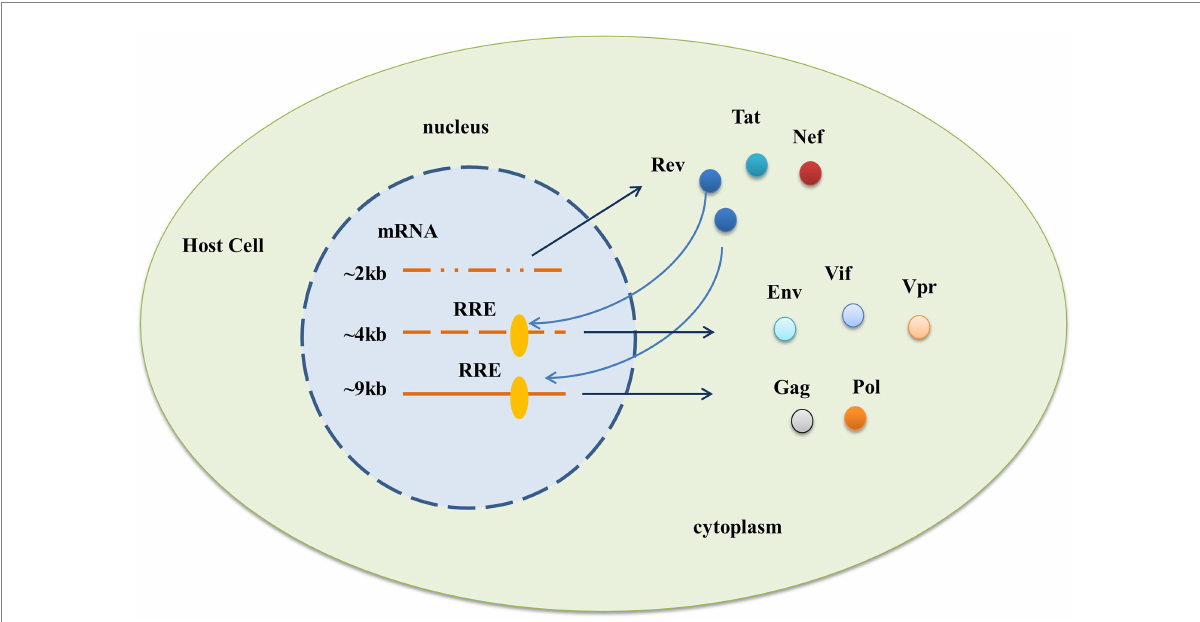
FIGURE 1 Functional requirement of the HIV-1 RRE. After HIV-1 enters the cell, three different mRNAs are produced through diverse editing, and the action of RRE allows the expression of viral proteins in two phases. In the early stage, only ~2 kb of fully edited transcripts can be directly transported out of the nucleus to express Rev, Tat, and Nef proteins, while partially edited ~4 kb and unedited ~9 kb transcripts containing the complete RRE sequence cannot be transported out of the nucleus. At a later stage of expression, the Rev protein reaches a threshold outside the nucleus, shuttles back to the nucleus, and brings both parts of the mRNA into the cytoplasm through binding with the RRE to express viral proteins such as Env, Vif, Vpr, and Gag, Pol,